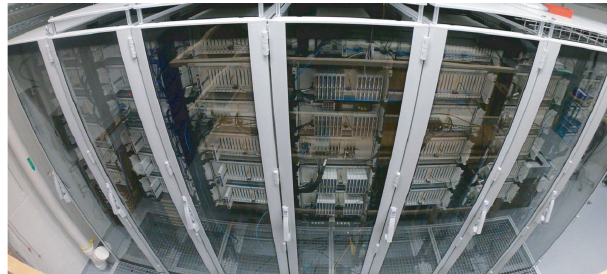
FIG. 10. Photograph of the full-scale acquisition, computation, and control